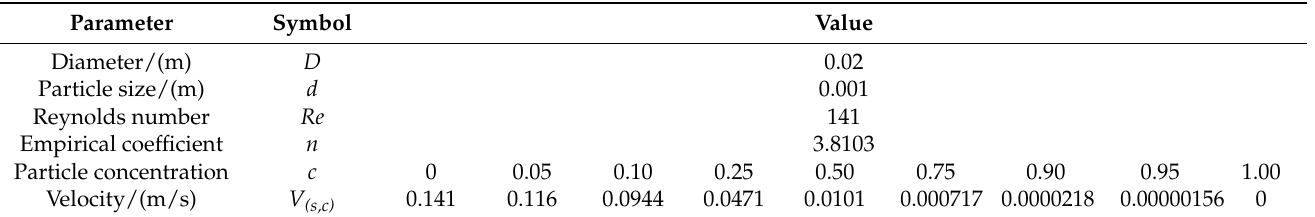
Table 2. Predictions of the Richardson empirical